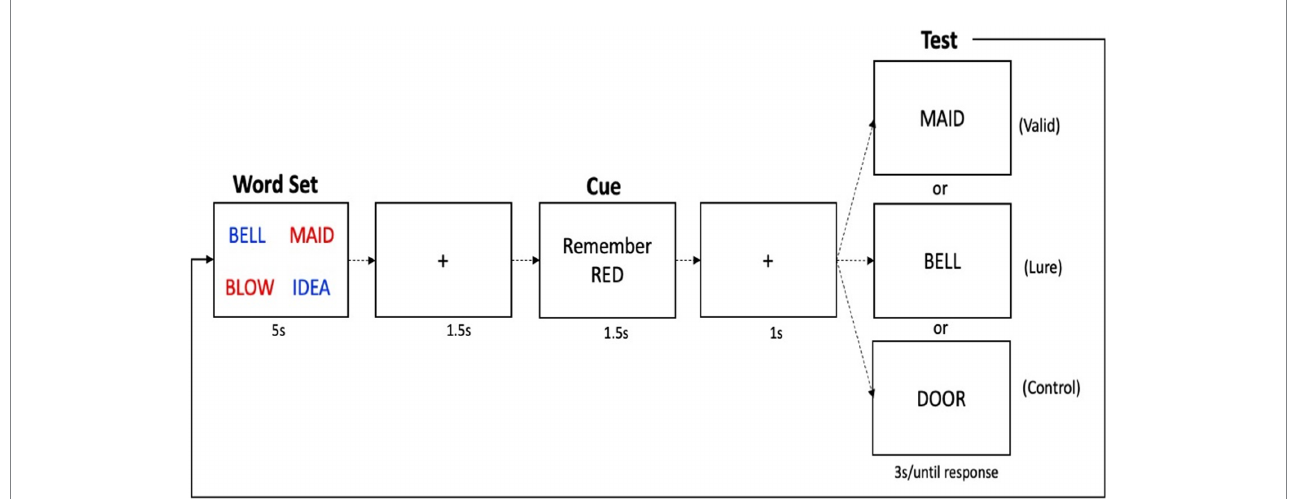
FIGURE 2 Schematic of the suppress task. One trial is shown, in which first the memory set is given, followed by a delay, a cue to remember either the red or blue words (red in this case), followed by a recognition probe, which asks “was this word one of the words you were supposed to remember?” Shown here are the three types of possible probes for each trial, although on each trial, only one probe is given.